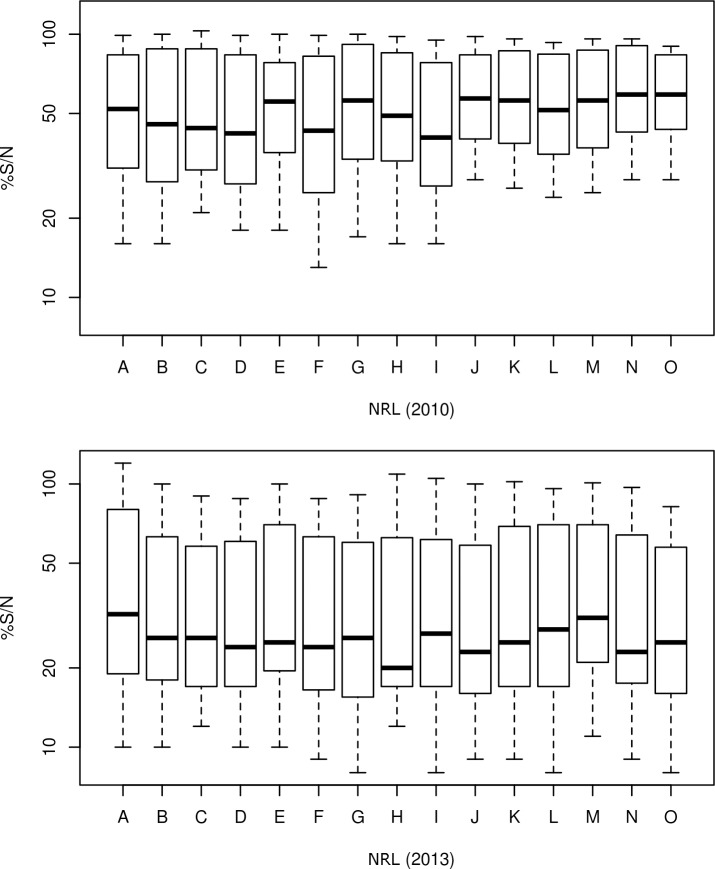
Box plot representing %S/N obtained with the ID screen WNV competition kit by each NRL during the 2010 and 2013 IPLTs.A single letter, A-0, refers to a unique NRL in 2010 and 2013.